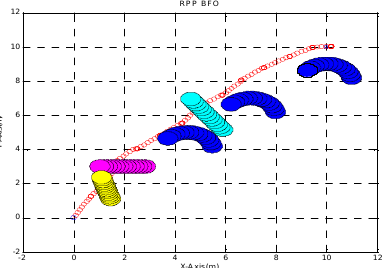
Fig. 13. 1st scenario pathfor case3 .